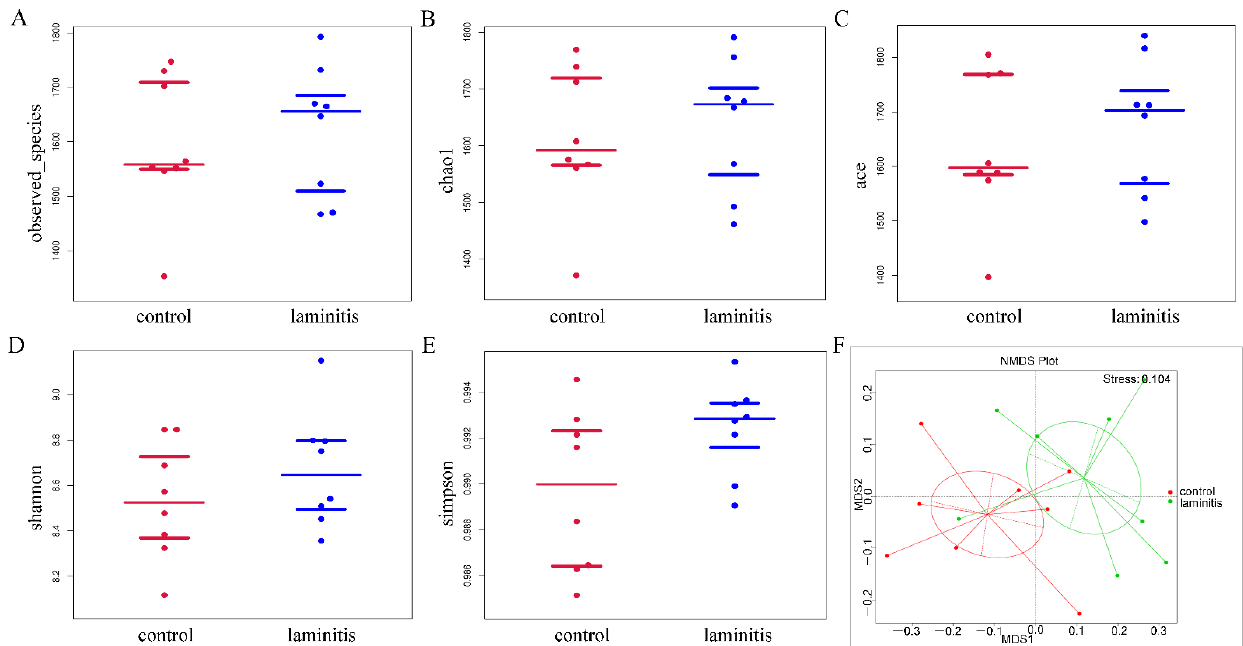
Figure 2. The composition of ruminal bacterial community comparison of the rumen microbiota richness and diversity in terms of ( A ) observed species, ( B ) chao 1, ( C ) ace, ( D ) Shannon index, and ( E ) Simpson index; ( F ) non-metric multidimensional scaling (NMDS) plot of pair wise Bray–Curtis dissimilarities between control and laminitis cows.